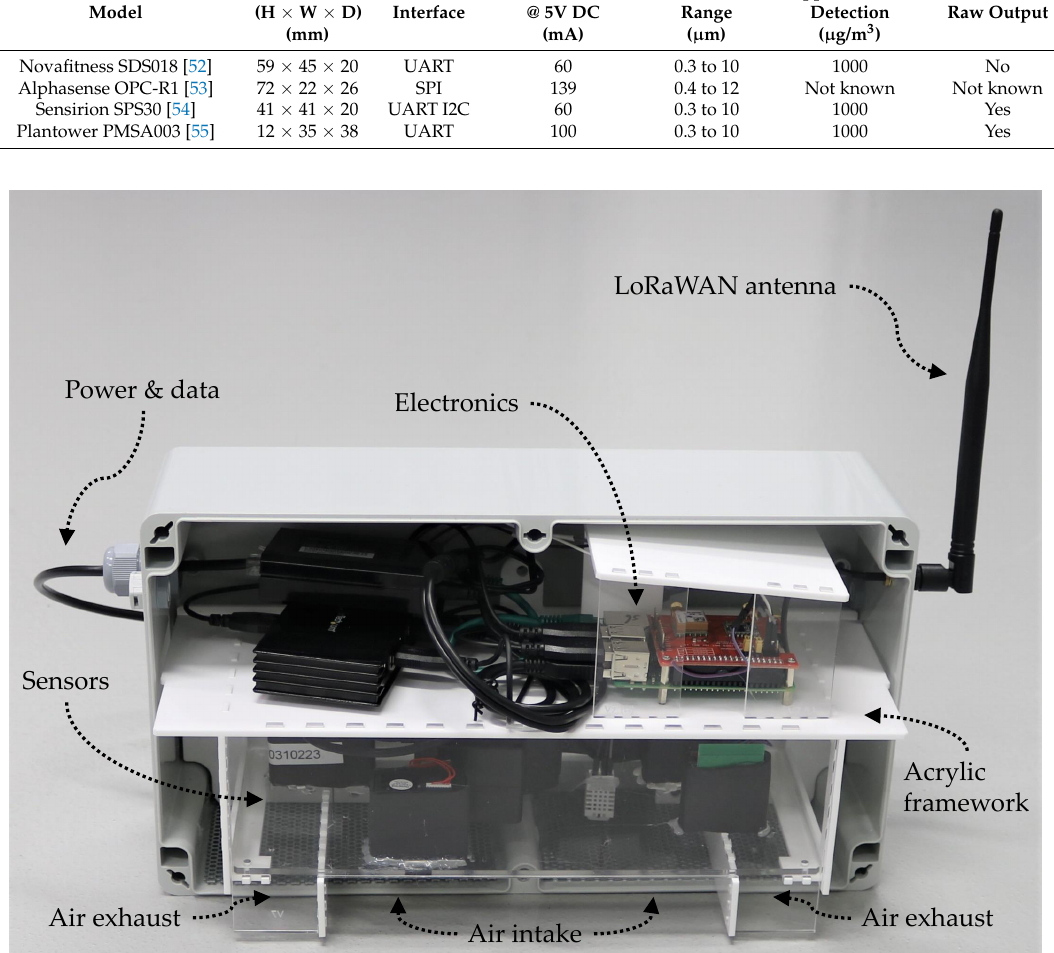
Figure 6. Version 2 of the Air Quality (AQ) Internet of Things (IoT) device in a landscape orientation with the enclosure lid removed. The acrylic framework comprises of (i) the electronics section containing a Raspberry Pi 3, Dragino LoRaWAN Hardware Attached on Top (HAT) and power distribution hardware; (ii) the sensor housing containing five Particulate Matter (PM) sensors, one temperature and humidity sensor and; (iii) the air intake and exhaust, separated by the two vertical acrylic